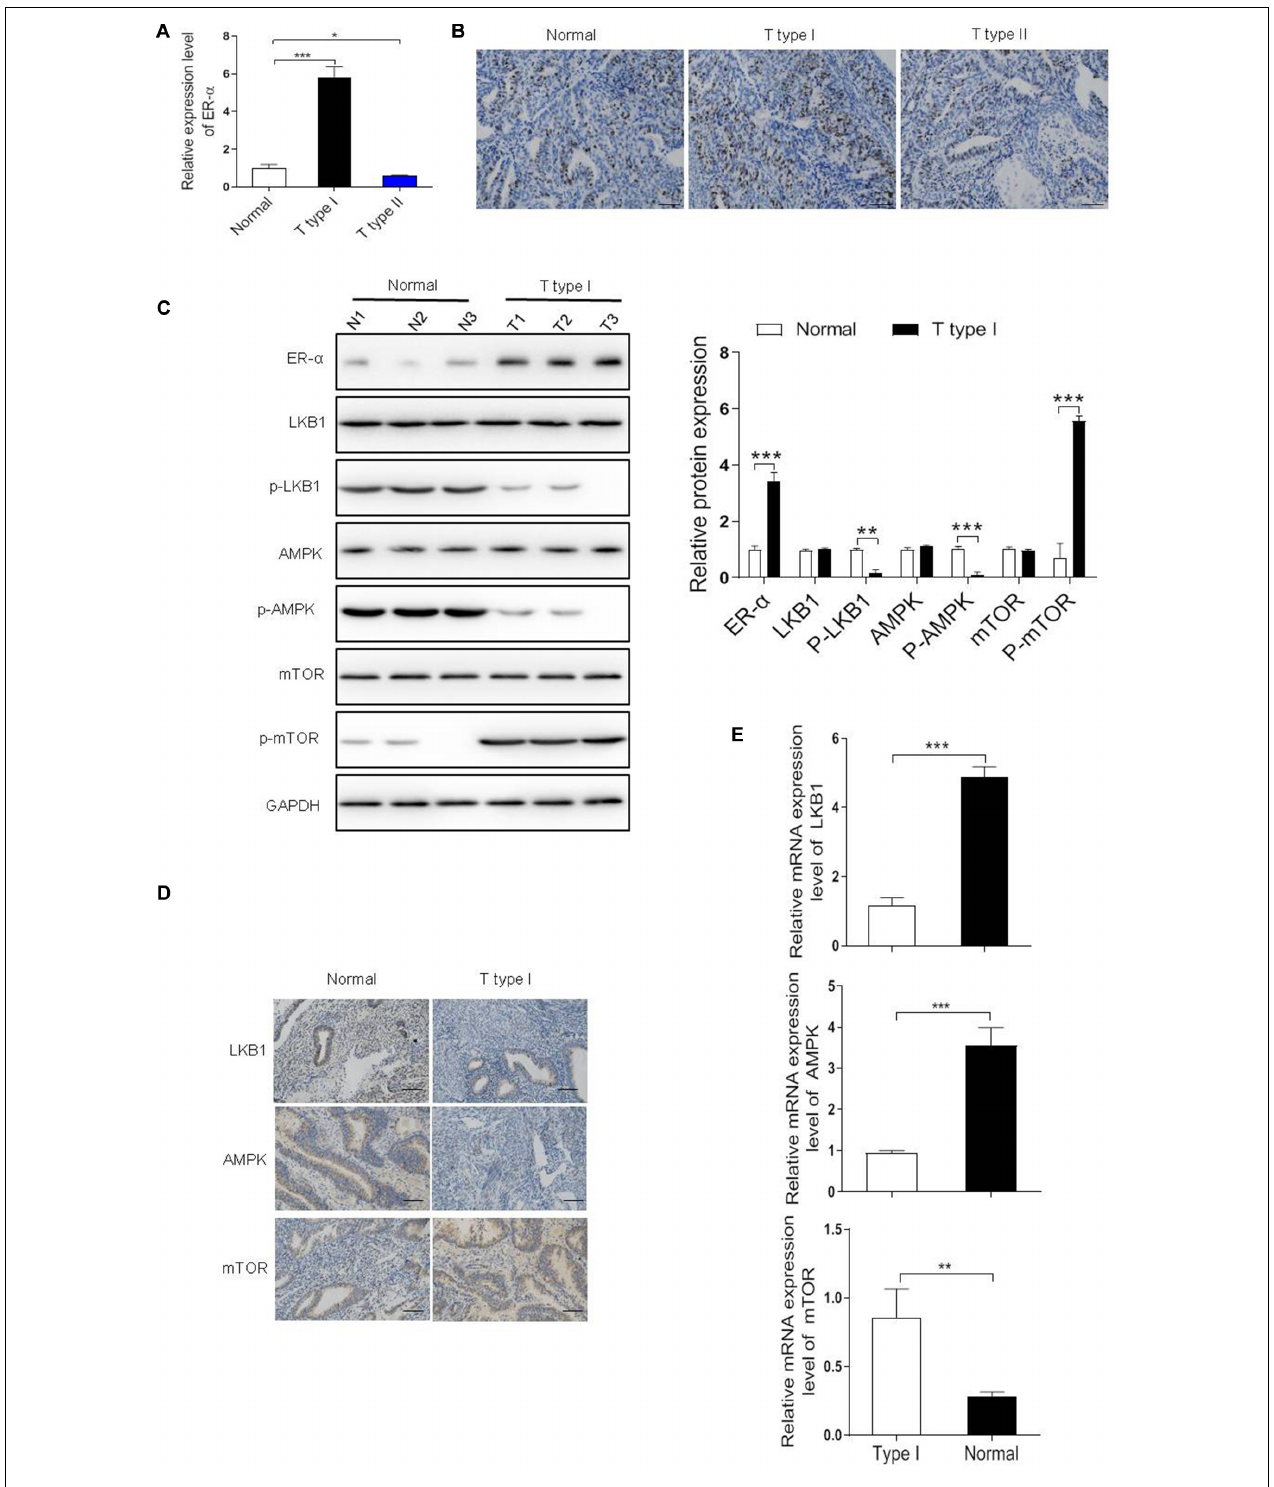
FIGURE 1 | Estrogen receptor- α (ER- α ) suppressed the LKB1/AMPK pathway in the ER- α -positive EC. (A,B) The expression level of ER- α in different subtypes of EC clinical samples and normal endometrial tissues were assessed by qRT-PCR and IHC assays. Bar = 100 µ m. (C) Representative blot and analyses were performed for the protein levels of ER- α , LKB1, p-LKB1, AMPK, p-AMPK, mTOR, p-mTOR in type I EC tumor samples and normal endometrial tissues ( n = 3). (D,E) The expression level of LKB1, AMPK, mTOR in type I EC tumor samples and normal endometrial tissues were assessed by qRT-PCR and IHC assays. Bar = 100 µ m. The results of quantification were showed as the mean ± SD, * p < 0.05, ** p < 0.01, *** p < 0.001 vs. the normal group.